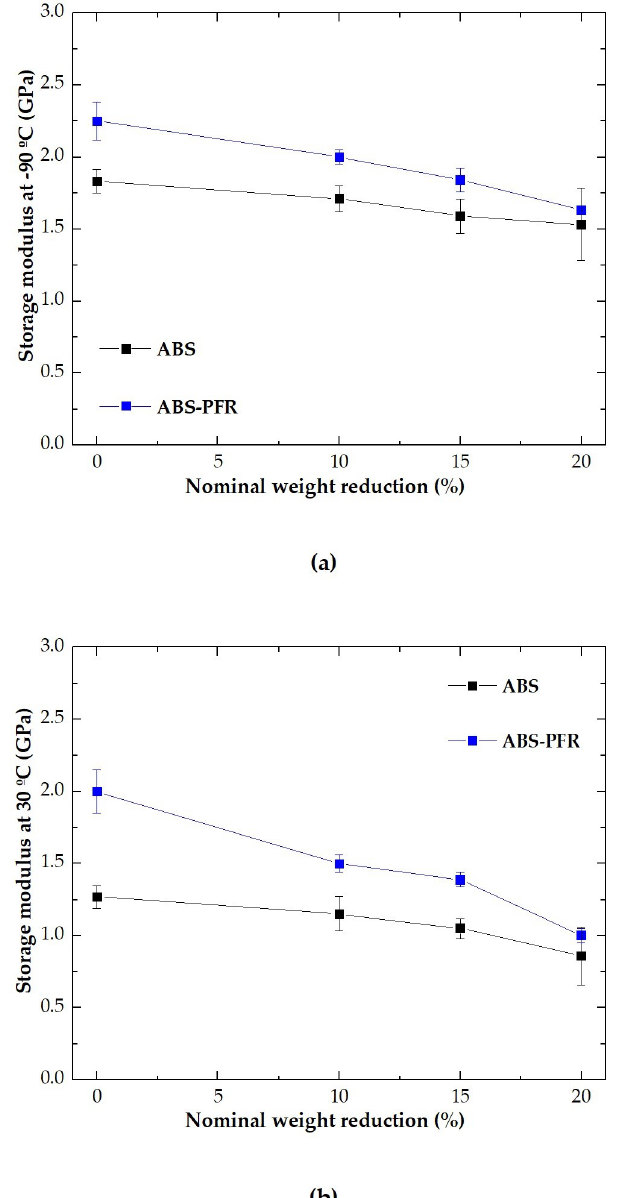
Figure 6. Variation of the storage modulus of ABS and ABS/PFR with the nominal weight reduction at ( a ) − 90 ◦ C and ( b ) 30 ◦